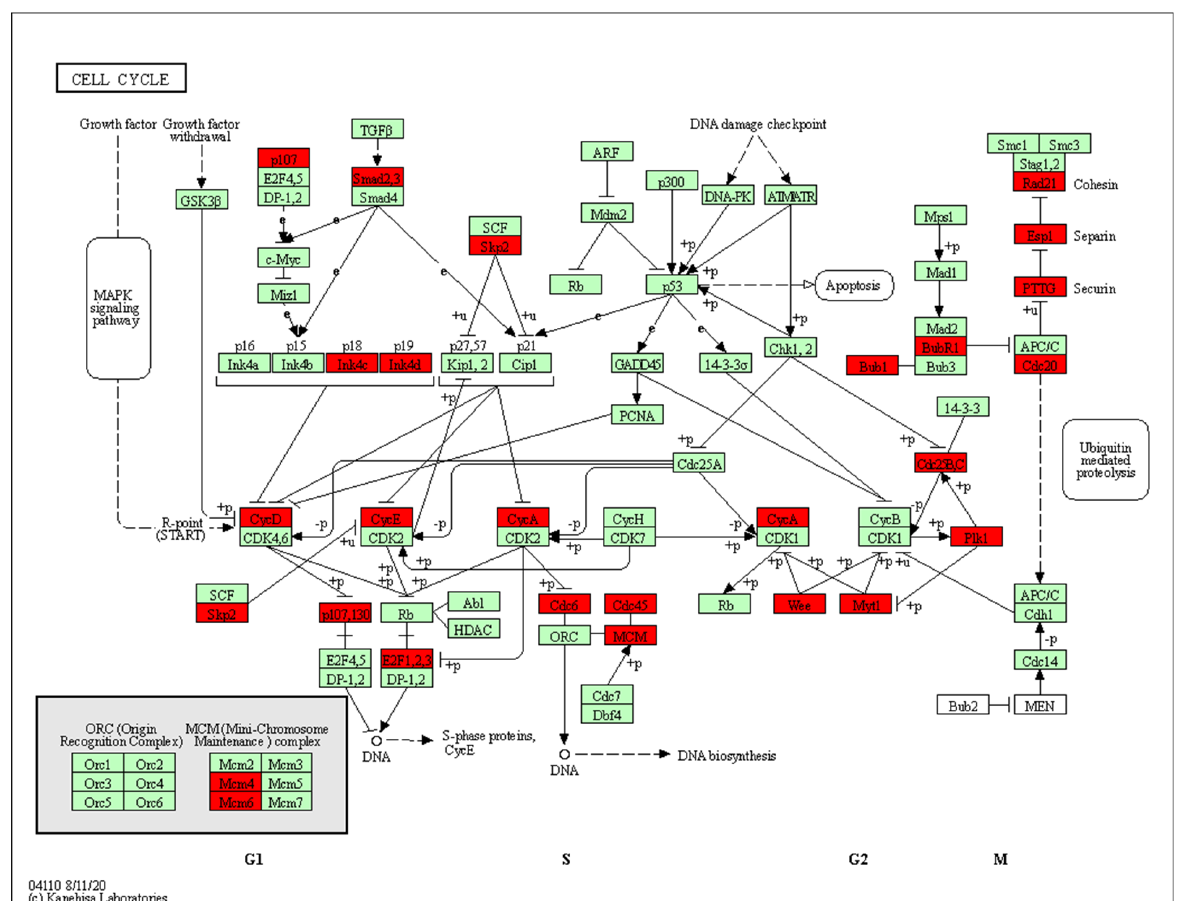
Figure 2. Cell cycle perturbations by polymyxin B. Red boxes present the proteins encoded by up-regulated genes; green boxes present the proteins encoded by down-regulated genes.